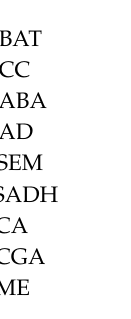
s1. Table S1. Patient demographics for TCGA Pan-Cancer dataset. Table S2. Genes encoding GABA shunt-proximal enzymes. Table S3. RT-PCR primers for GABA system genes. Figure S1. Scatter pots showing co-expression of transcripts encoding GABA shunt-proximal enzymes with ABAT transcript expression. Figure S2. Kaplan-Meier estimate of overall survival of patients with upregulated DNMT1 . Figure S3. Kaplan-Meier estimates of overall patient survival for selected mesenchymal-to-epithelial transition pathway genes enriched in patients with upregulated ABAT transcript